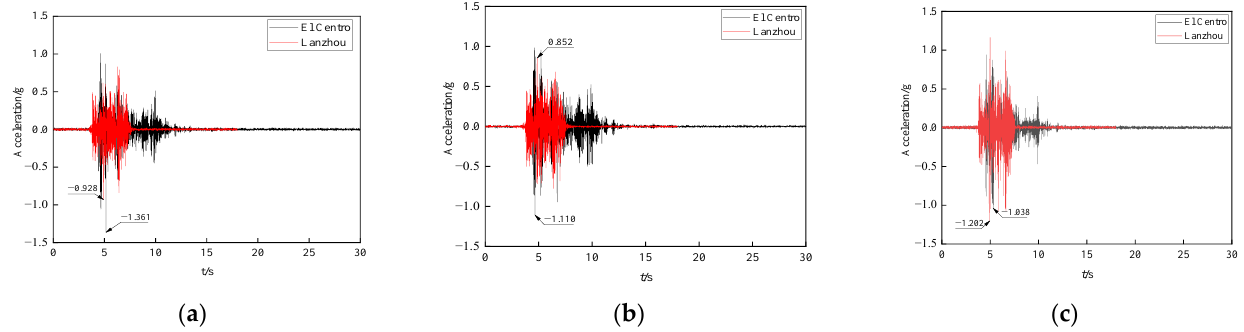
in Figure 10. This indicated that, for irregular bridges, simply supported straight beams in some cases. In addition, redundant constraints could also reduce the mid-span acceler- did not provide better seismic performance than curved beams in some cases. In addition, ation response. redundant constraints could also reduce the mid-span acceleration response.